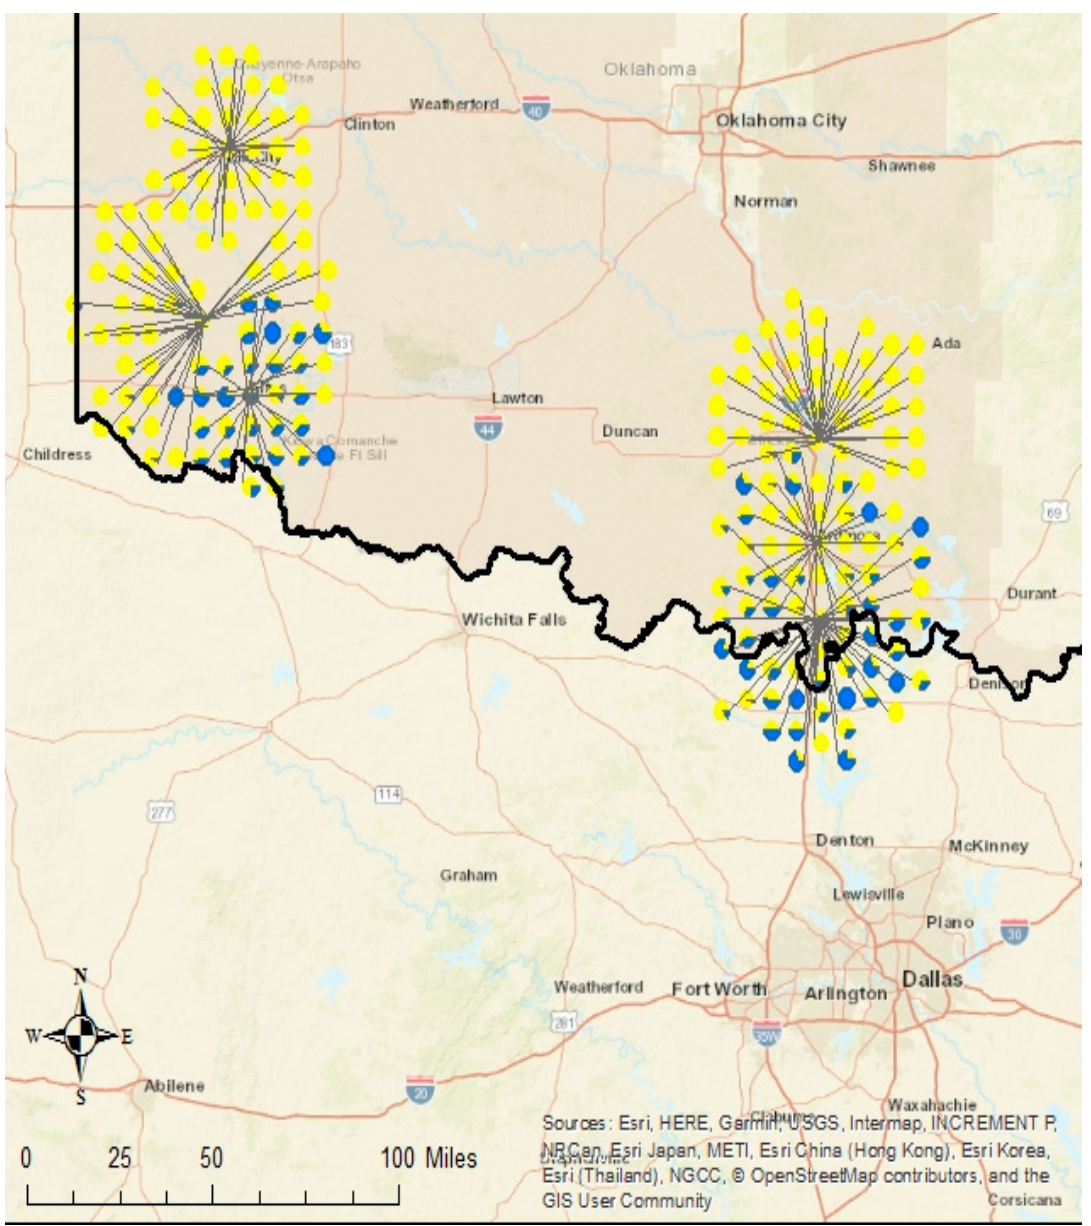
Figure 2. Proportion of total Ae. aegypti (blue) and Ae. albopictus (yellow) collected by site along the western and eastern Oklahoma transects between June and August 2017.